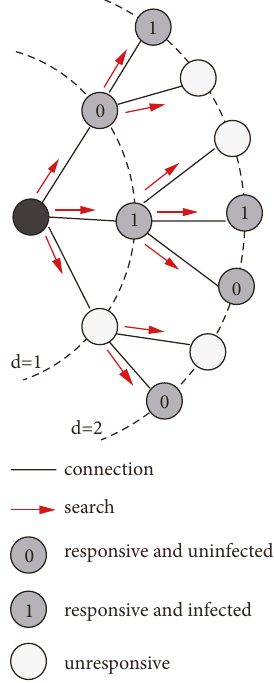
Figure 1: A schematic diagram of the working process using the flooding